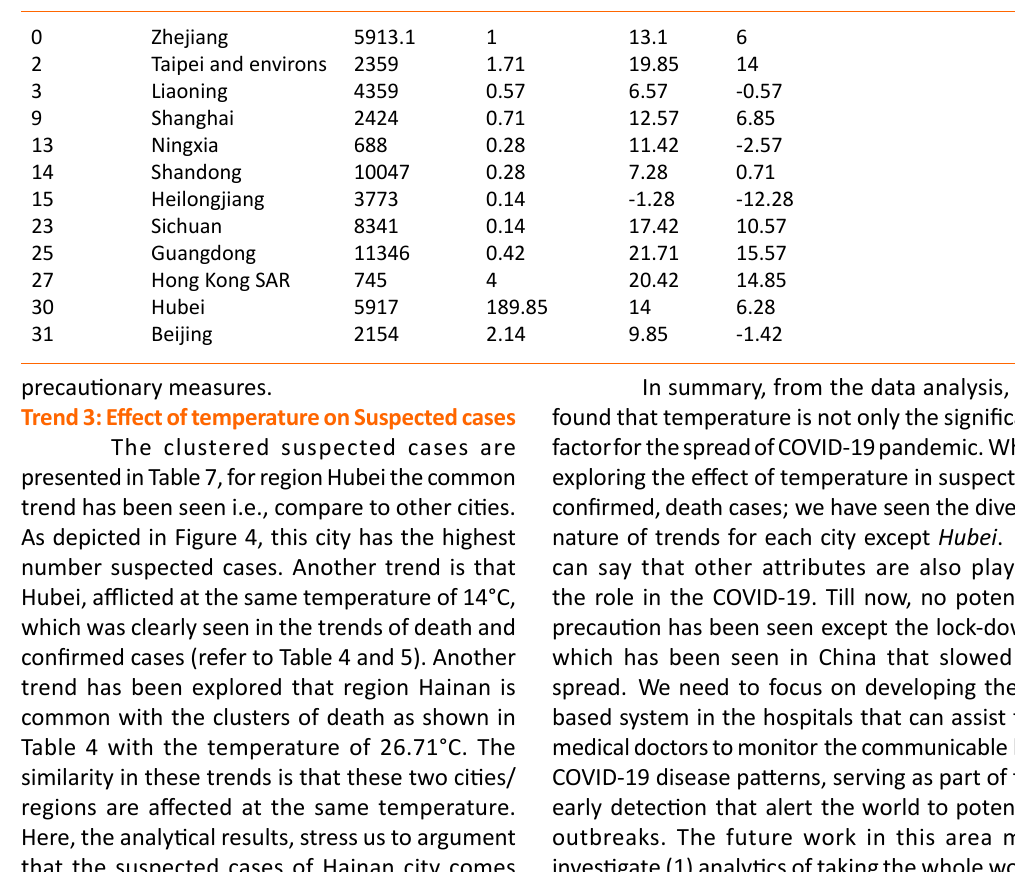
Table 5. K-means Cluster results on Confirmed COVID-19 cases Vs Temperature Cluster ID